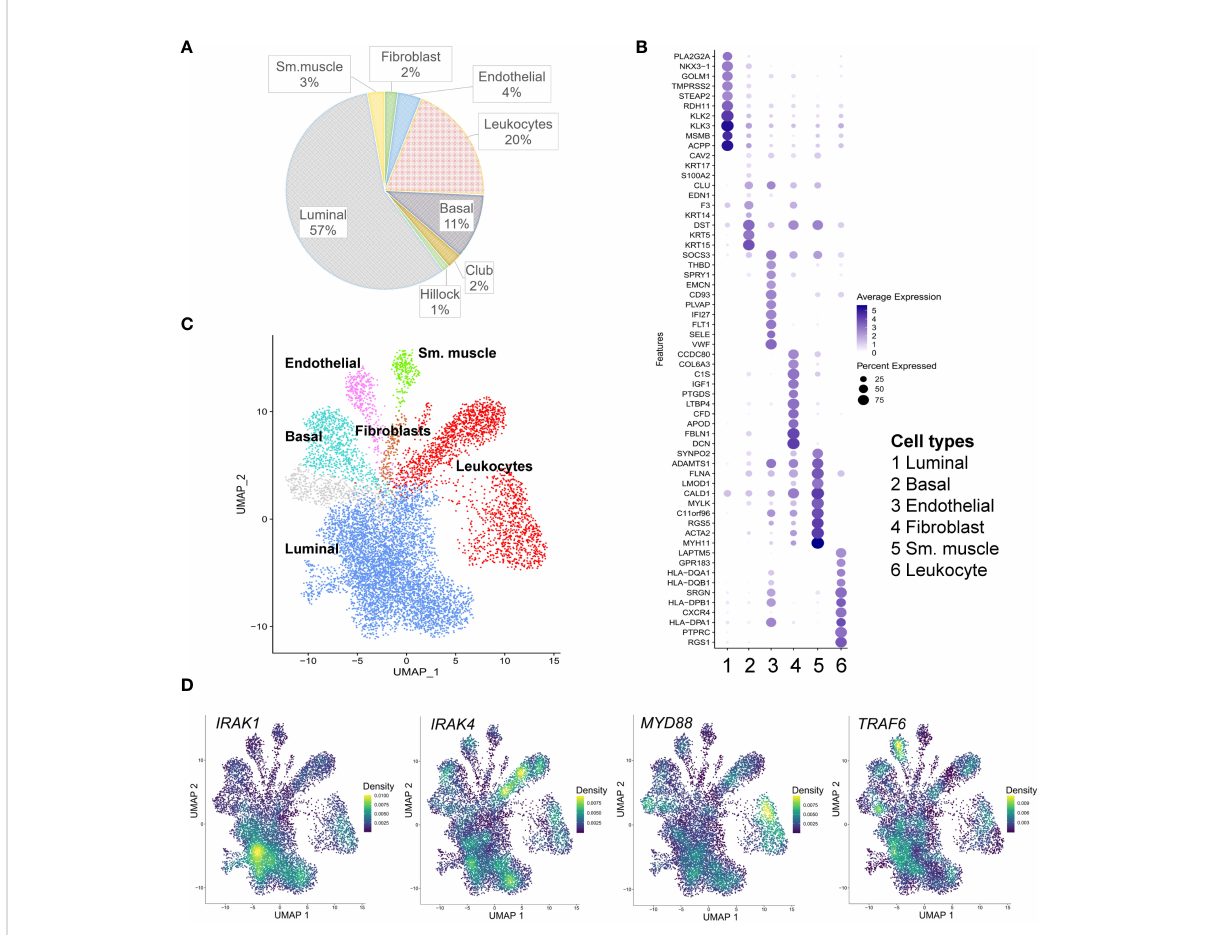
FIGURE 1 Single cell RNA-sequencing (scRNA-seq) analysis of IRAK1 , IRAK4 , Myd88 and TRAF6 expression in prostate cancer. (A) Cell type proportions within the merged scRNA-seq dataset from eight radical prostatectomy specimens (17). (B) Dot plot of top 10 marker genes for each of the displayed cell type clusters. Dot size and color represent the percentage of marker gene expression and average scaled expression value (minimum percentage expression 0.2%). (C) Cell type clusters detected in prostate cancer are presented in the uniform manifold approximation and projection (UMAP). (D) Density plots of IRAK1, IRAK4, Myd88 and TRAF6 expression in prostate cancer sm. muscle: smooth muscle